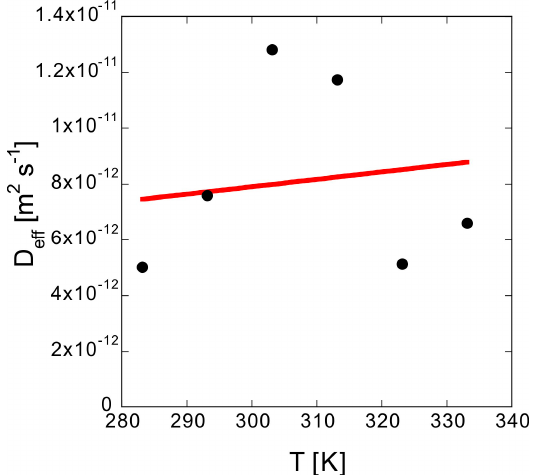
Figure 10. Temperature dependence of D eff . The circles are experimental data, while the red solid line is the proportional fitting. Table 5. Effect of temperature on parameters 1 of methylene blue elution.